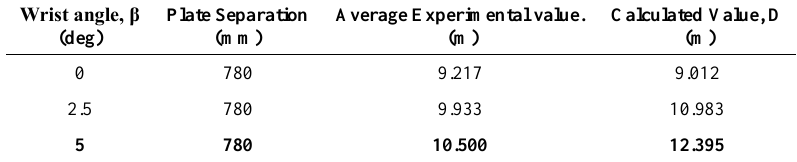
Table 5. The table showing a comparison of experimental data and calculated